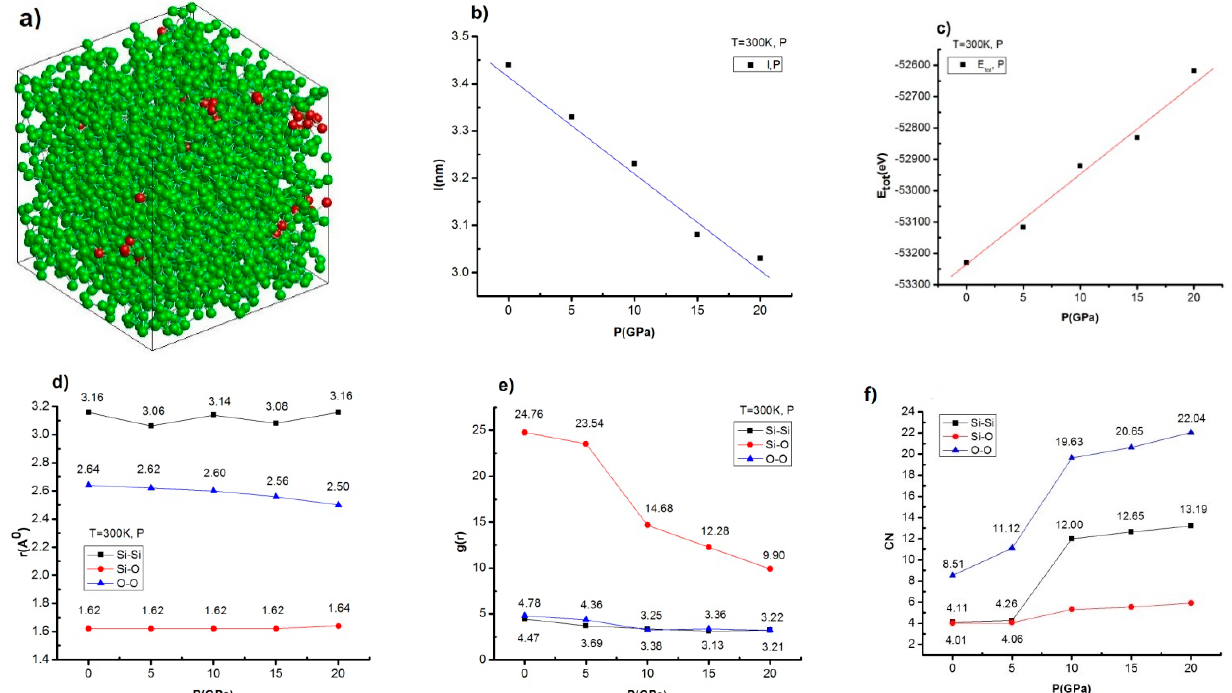
Figure 2. Shape ( a ), l ( b ), the Etot of the system ( c ), r ( d ), g(r) ( e ), coordinate number ( f ) of bulk SiO2 at T = 300 K with different values of p . The obtained results demonstrate the fact that bulk SiO 2 at T = 300 K, P = 0 GPa has the form of a cube (Figure 2a) with the nanoscale, l = 3.44 nm, and the E tot is equal to − 53,230 eV. The form of RDF gives the lengths of the links (r) of Si-Si, Si-O, O-O equal to r Si-Si = 3.16 Å, r Si-O = 1.62 Å, r O-O = 2.64 Å. These correspond to the heights of RDF g Si-Si = 4.47, g Si-O = 24.76, g O-O = 4.78. The average CNs were calculated by the formula (4) and have the following values: CN Si-Si = 4.11, CN Si-O = 4.01, CN O-O = 8.51, respectively. The number of structural units SiO 4 , SiO 5 , SiO 6 are correspondingly 1978, 63, and 1, whereas O-Si-O links angle is 105 ◦ and Si-O-Si is 140 ◦ . When P increases from P = 0 GPa to 5, 10, 15, 20 GPa, the size (l) decreases from l = 3.44 nm to l = 3.33, 3.23, 3.08, 3.03 nm (Figure 2b), which correspond to E tot increasing from E tot = − 53,230 eV to E tot = − 53,116, − 52,921, − 52,831, − 52,619 eV (Figure 2c), respectively. RDF had the position r slightly changed (from 3.08 Å to 3.16 Å for Si-Si), (1.62 Å to 1.64 Å for Si-O), and (2.50 Å to 2.64 Å for O-O) (Figure 2d), which corresponds to a decrease of g(r) (from 4.47 to 3.21 with Si-Si), (24.76 to 9.90 with Si-O), (4.78 to 3.22 with O-O) (Figure 2e). The average CNs (4) increased from 4.11 to 13.19 for Si-Si, 4.01 to 5.91 with Si-O, 8.51 to 22.04 with O-O (Figure 2f), while the number of SiO 4 structural units decreased from 2975 atoms to 2906, 1928, 1536, 983 atoms. This number of SiO 5 increases from 121 atoms to 345, 1855, 2070, and 2163 atoms, whereas for SiO 6 it increases from seven atoms to 32, 640, 932, and 1450 atoms. The O-Si-O links angle remains constant at 105 ◦ . The results obtained show that when P increases at T = 300 K, the length (r), g(r), CN, and angle of the links will strongly change. With r O-O , g Si-O strongly decreases and CN O-O , CN Si-Si strongly increases, and this leads to a sudden decrease in the number of SiO 4 structural units and the sudden increase of SiO 5 , SiO 6 . At T = 1273 K values are shown in Figure 3.